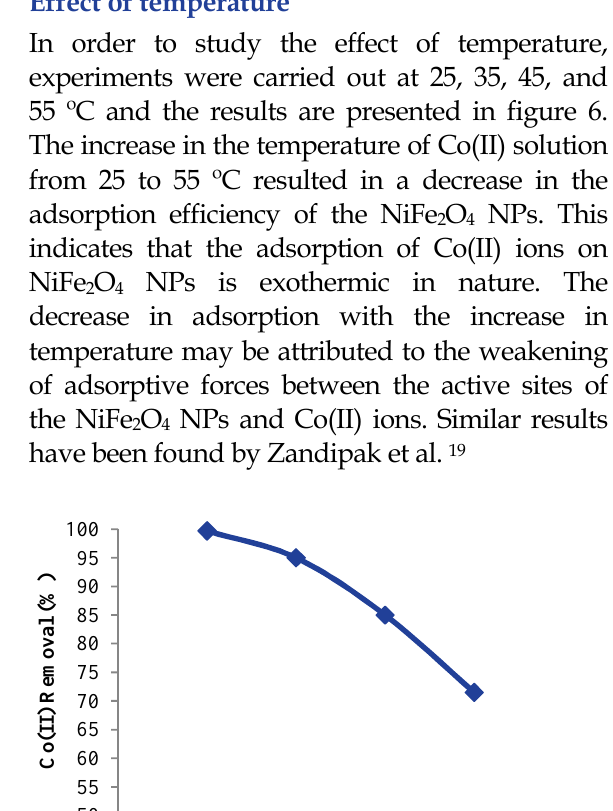
Figure 5. Effect of adsorbent dose on the removal efficiency of Co(II) by NiFe (C = 60 mg/l, solution pH = 7, contact time = 70 0 minutes, and temperature = 25 ºC)